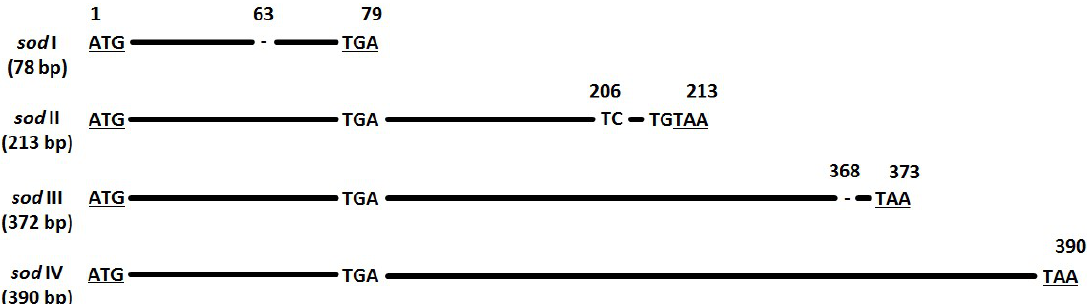
Figure 3. Nucleotide alignment of the four sod types (I–IV). Nucleotide positions and differences are displayed in relation to sod type IV (390 bp). Start and stop codons are underlined.